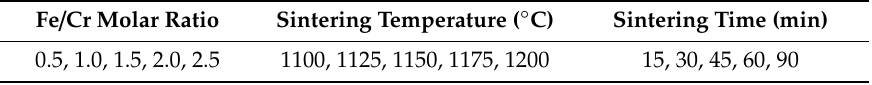
Table 1. The process parameters of black ceramic tile